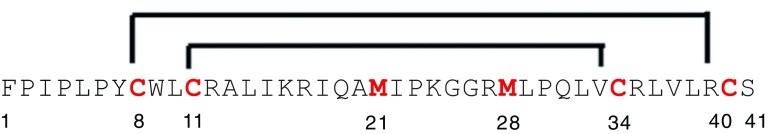
Sequence for Super Mini-B (SMB).SMB (41 amino-acid residues; 1-letter amino-acid notation) with the N- and C-terminal Phe-1 and Ser-41 are indicated, and also the sulfur-containing cysteines (Cys-8, Cys-11, Cys-34, Cys-40) and methionines (Met-21 and Met-28) in red. The two disulfide-linkages are shown between Cys-11 and Cys-34 and between Cys-8 and Cys-40.